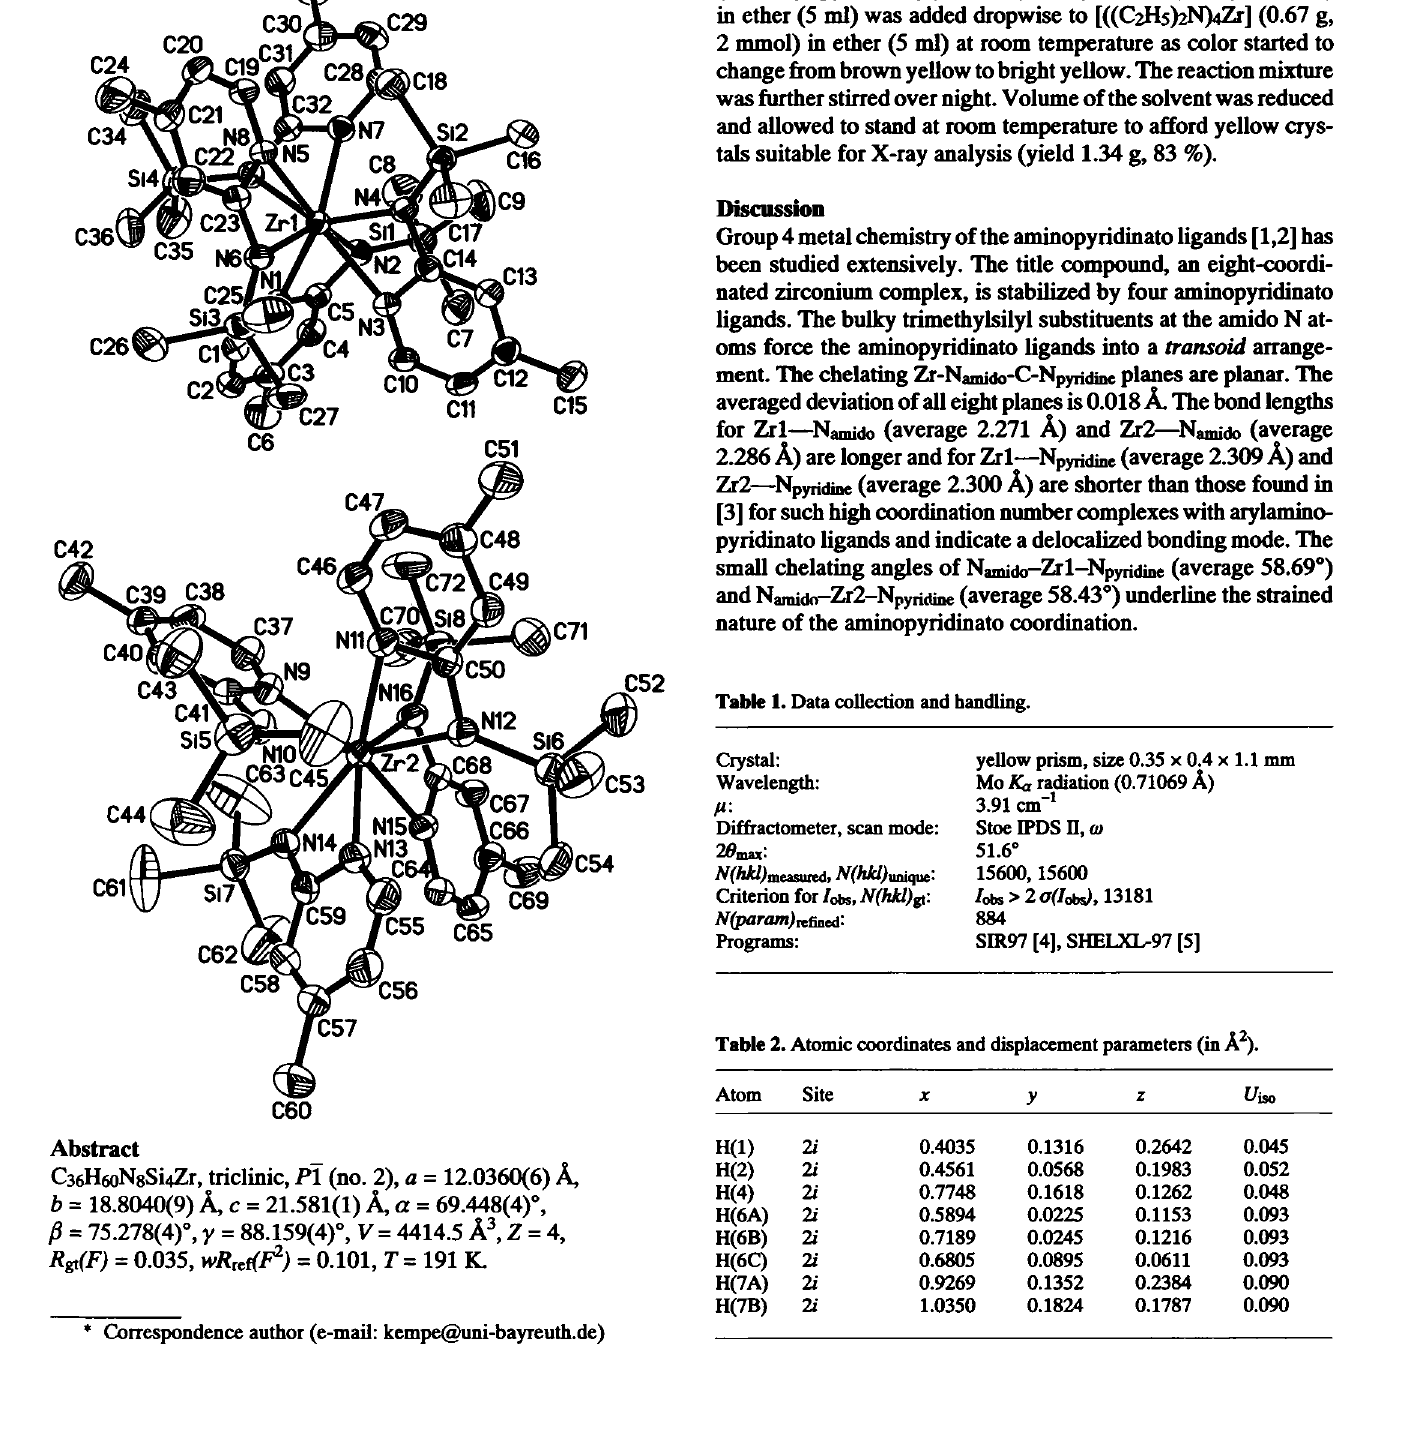
Table 2. Atomic coordinates and displacement parameters (in A 2